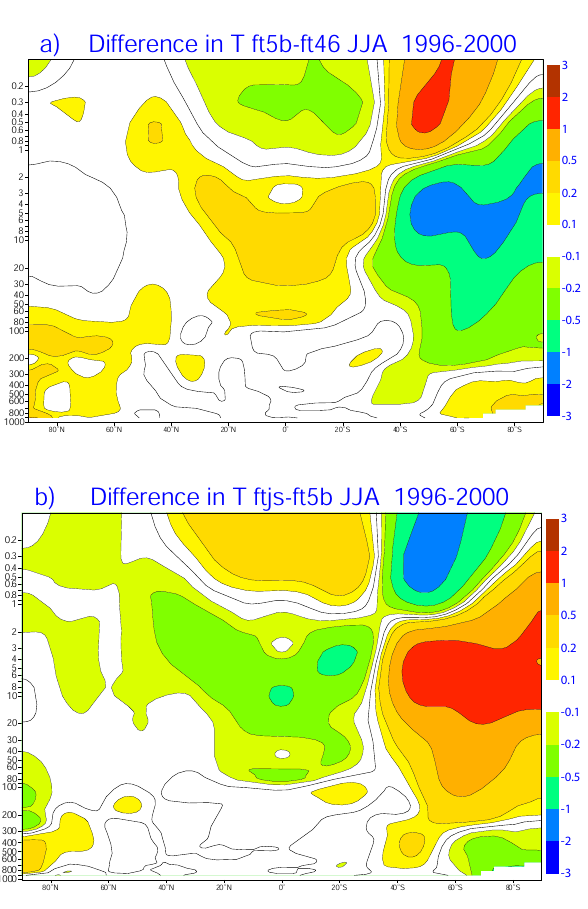
Fig. 10. Differences in temperature (K) averaged over June-July- August (JJA) 1996–2000 between the ECMWF runs (a) ft5b (CoMeCAT CH 4 in the radiation scheme) and ft46 (GEMS CH 4 climatology in the radiation scheme); (b) run ftjs (CoMeCAT CH 4 and H 2 O in the radiation scheme) and run ft5b (CoMeCAT CH 4 in the radiation scheme). Colour scale goes from most negative differ- ences (dark blue) to most positive differences (dark